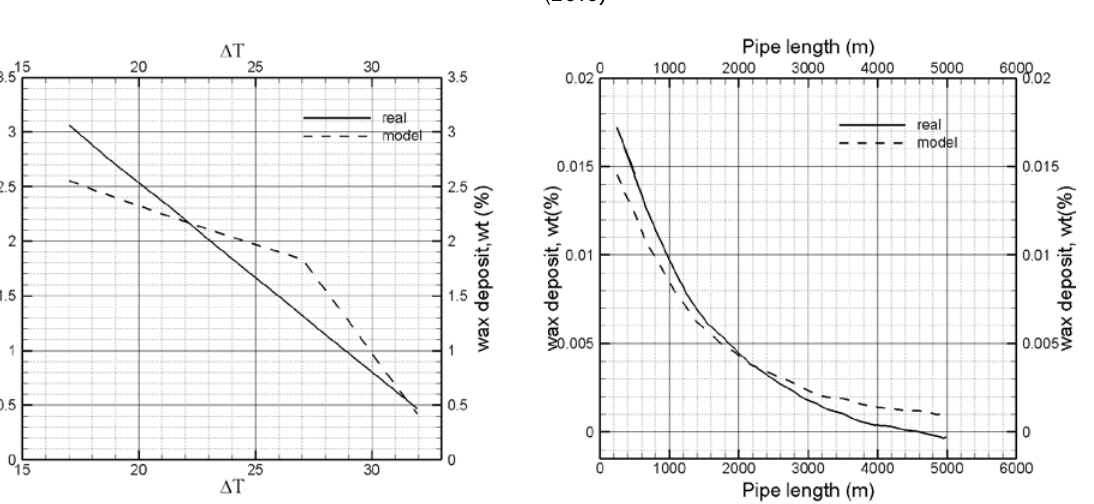
Figure 21 Comparison between real result and developed model for works by Mahto and Kumar